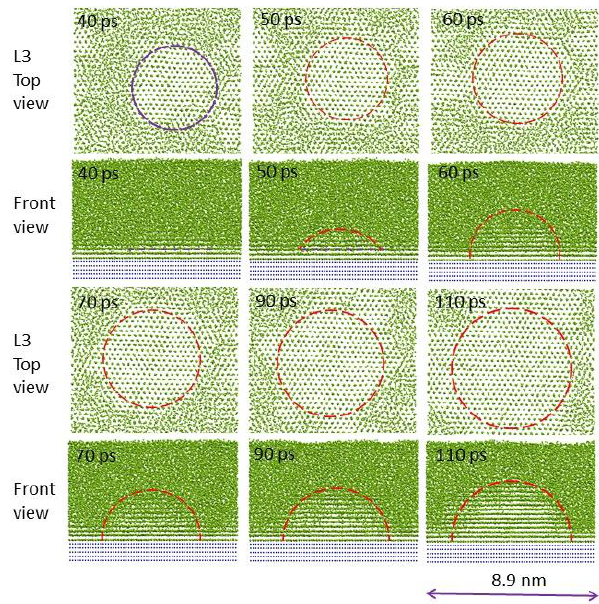
Figure 13. Time-averaged atomic positions of a simulation system with 8% lattice misfit demon- strating the unconstrained cap formation process at a constant temperature. Nucleation occurred at ∆ T n = 131 K on a substrate of 2r N = 8.9 nm to provide the 2D nucleus of 2r n = 4.3 nm (the purple dashed circle at t = 40 ps). With increasing time, the 2D nucleus grows isothermally initially into a spherical cap ( t = 50 ps) and then hemispheres with increasing radius ( t > 60 ps).